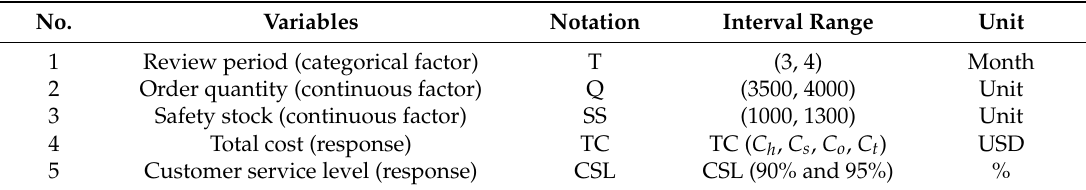
Table 4. The interval ranges of the